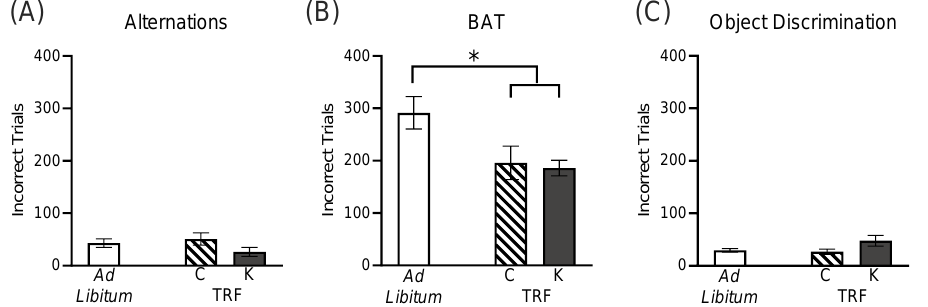
Figure 3. Behavioral performance of aged rats across diet groups and feeding methods. ( A ) There were no differences across groups in ability to alternate between the left and right arms of the maze. ( B) Lifelong time-restricted feeding, regardless of macronutrient composition, improved ability to acquire the object-in-place rule required for criterion performance on the BAT task to a degree that was comparable to performance in young (4 – 8 mo) rats of the same strain. ( C) All rats were able to perform an object discrimination task similarly, indicating no sensorimotor deficits or motivation differences across groups that would confound BAT task performance. All data are group means 1 SEM; * indicates p < 0.05. Data from the cohort presented here were also compared to young animals from other previously run cohorts that underwent identical BAT behavioral testing to assess how life-long TRF influenced cognitive outcomes in advanced age. While old rats made significantly more incorrect trials than young prior to reaching criterion performance on BAT testing (F [1,64] = 19.22, p < 0.001), TRF-fed rats overall performed significantly better than ad lib fed rats regardless of age group (F [1,64] = 7.64, p < 0.01). Moreover, when the ketogenic and control groups of TRF fed rats were compared to young rats, there were was no significant difference in performance across the three groups (F [2,38] = 1.35, p = 0.27). In contrast, the ad libitum-fed aged rats made significantly more errors than the young rats (T [39] = 4.40, p = 0.001). Together these data indicate that a mid-life intervention with TRF may prevent age-related cognitive deficits commonly observed on this task. Following BAT testing, a simple object discrimination control was utilized to ensure all rats were able to discriminate between two dissimilar objects and to assess potential differences in motivation or procedural impairments (Figure 3C). There was not a signif- icant difference in the number of incorrect trials required to reach a criterion performance on this control task across the 3 groups of rats (F [2,25] = 2.60; p = 0.10), nor was there an effect of feeding method (ad libitum versus time-restricted; F [1,29] = 0.82; p = 0.37). These data demonstrate all rats were able to discriminate between objects and are not visually im- paired, indicating BAT task performance was not hindered by physical or sensory deficits, but rather was likely to manifest from cognitive differences across diet groups that altered the rate at which animals could learn the object-in-place rule. 3.3. Time Restricted Feeding and the Ketogenic Diet Influence Gut Microbiome Composition and Beta Diversity At the phylum taxonomic level (Figure 4A,B), two phyla were found to significantly differ across diet groups: actinobacteria (F [2,27] = 11.49; p < 0.001) and deferribacteres (F [2,27] = 7.39; p = 0.002). While both TRF groups had significantly reduced abundance of actino- bacteria relative to the ad libitum fed group ( p < 0.01 for both comparisons), only the ke- togenic diet fed TRF group had significantly higher levels of deferribacteres than the ad libitum fed group (t [27] = 3.30; p = 0.006; Figure 4C) but not the control TRF fed group (t [27] = 0.38; p > 0.99). No other phyla differed by diet group or feeding paradigm ( p > 0.19 for all comparisons), nor did the ratio of firmicutes to bacteroidetes differ ( p > 0.30 for both